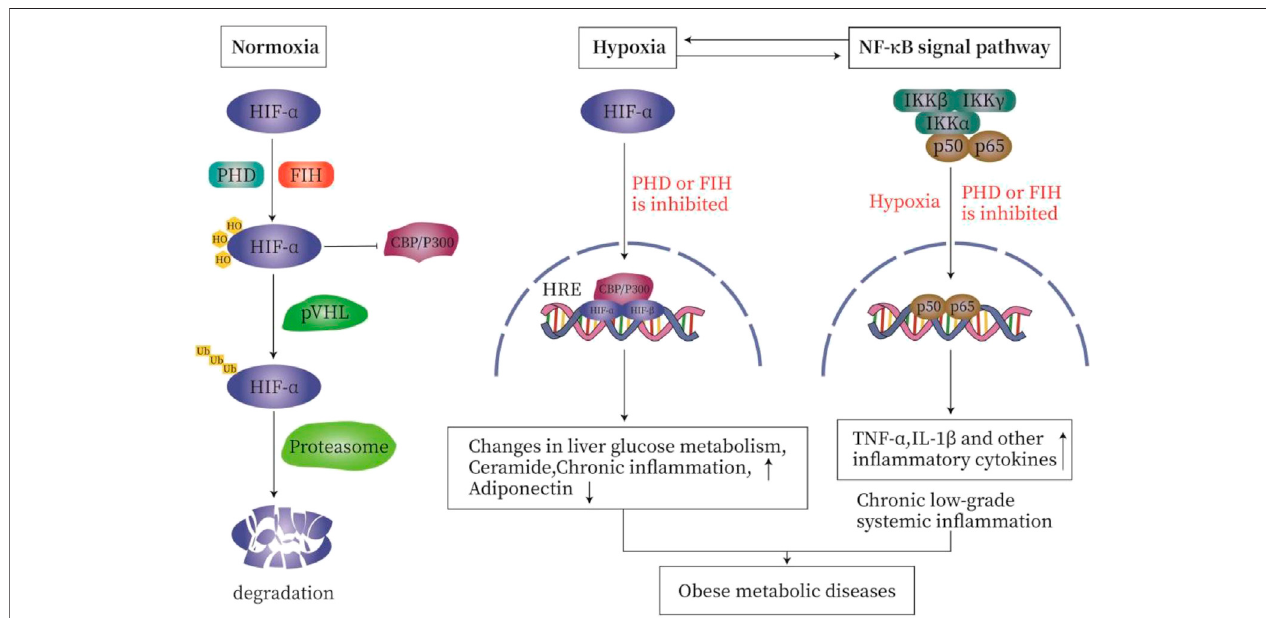
FIGURE 2 | The relationship between hypoxia and in fl ammation. Under normal oxygen (A) , the proline residues on the α subunit of HIF are hydroxylated by HIF prolyl hydroxylase, so that HIF is recognized and ubiquitinated by VHL E3 ubiquitin ligase. It is then rapidly degraded by the proteasome. Asparagine hydroxylation inhibits the interaction of HIF α with the co-activator cAMP response element binding (CREB)-binding protein (CBP) and histone acetyltransferase p300 (p300). During hypoxia (B) ,theenzymeactivitiesofPHDandFIHareinhibited,resultinginthestabilization ofHIF α subunit.Afterbeingtransportedtothenucleus, HIF α complexes with the β subunit, recruits p300 and CBP, and then binds to the hypoxia response element (HRE) in the target gene promoter to initiate transcription. Hypoxia and in fl ammation (C) . On the one hand, in fl ammation is usually characterized by tissue hypoxia or the stabilization of hypoxia-dependent transcription factors such as hypoxia-induciblefactor(HIF).Ontheotherhand,hypoxiaischaracterizedbysecondaryin fl ammatorychanges.Inordertomeetthechallengeofhypoxiaandensurecell survival, the regulation of HIF and nuclear factor- κ B (NF- κ B) occurs through oxygen-sensitive prolyl hydroxylase (PHD). Hypoxia activates NF- κ B through a pathway involvingI κ Bkinase- β (IKK β )activation,whichleadstophosphorylation-dependentdegradation ofI κ B α andtherelease ofNF- κ B.PHD andFIHregulatetheactivationof NF- κ B by regulating the activity of IKK β